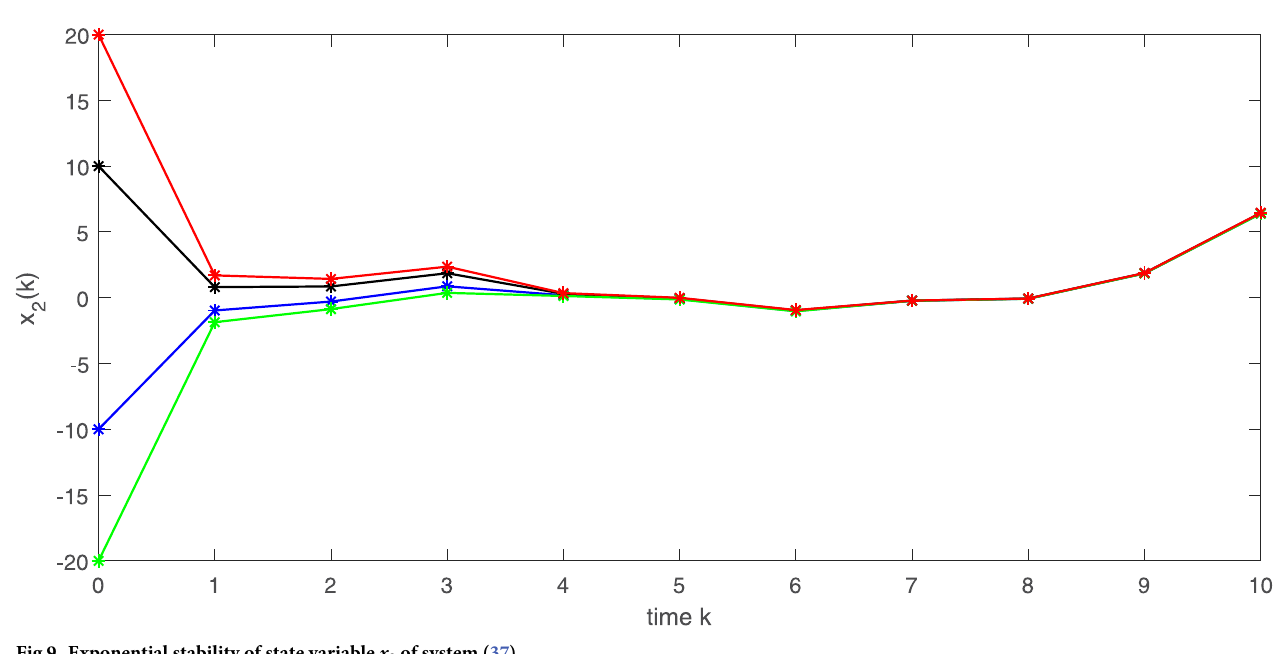
Fig 9. Exponential stability of state variable x 2 of system